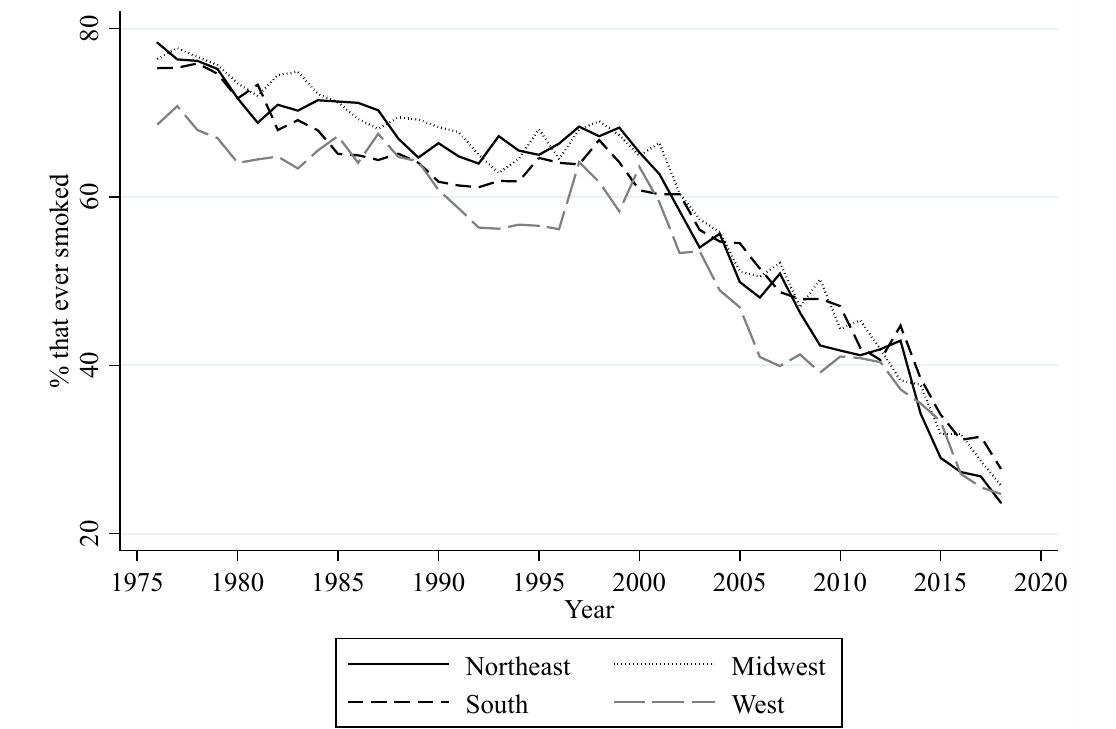
Figure 3. Annual rate of lifetime prevalence among U.S. high school seniors.